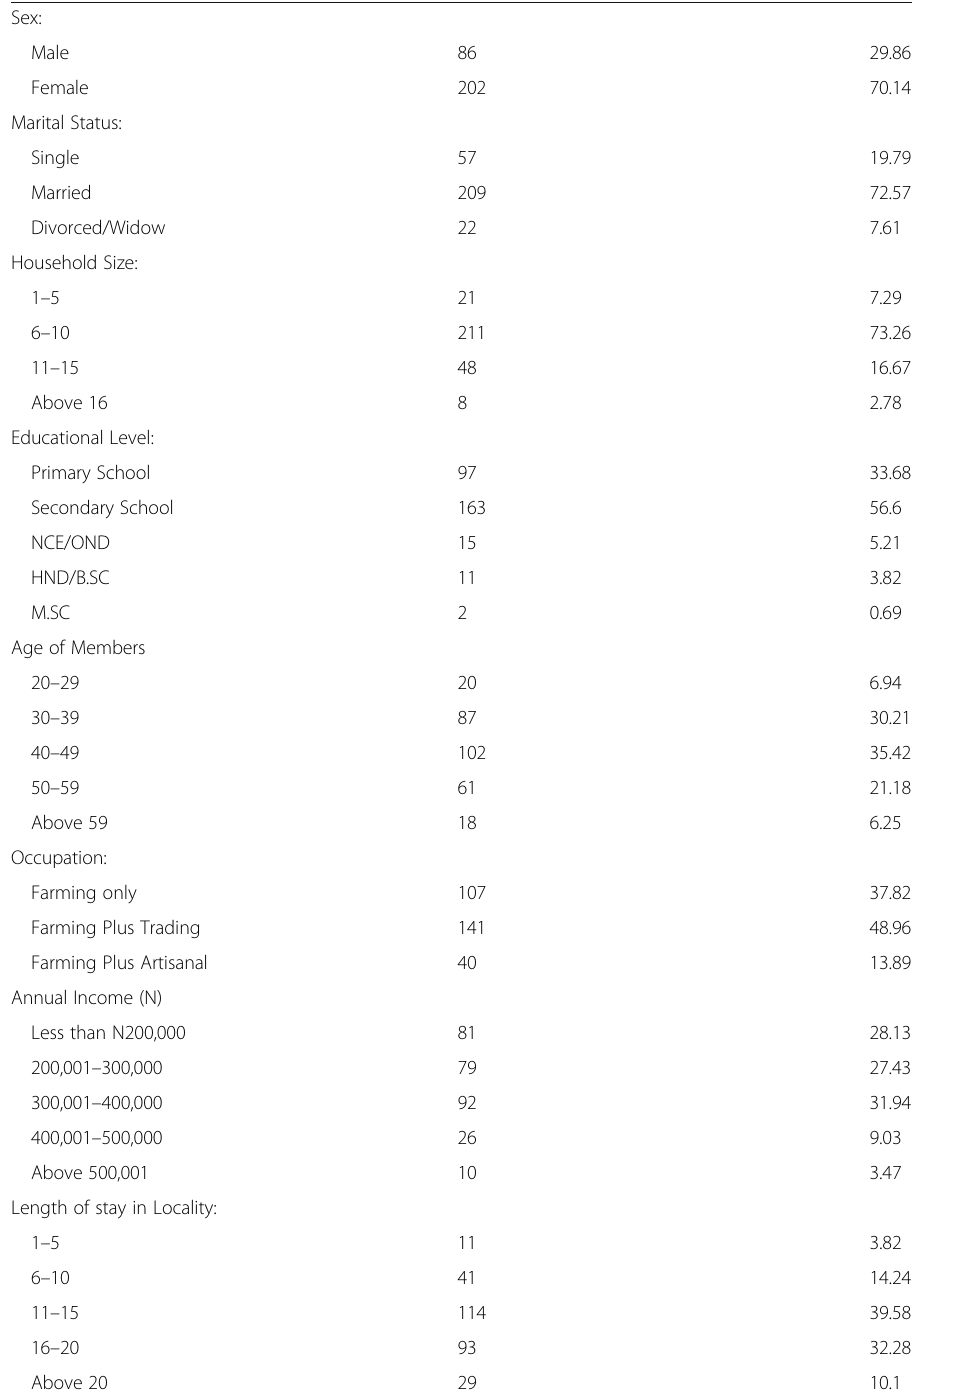
Table 1 Group Members ’